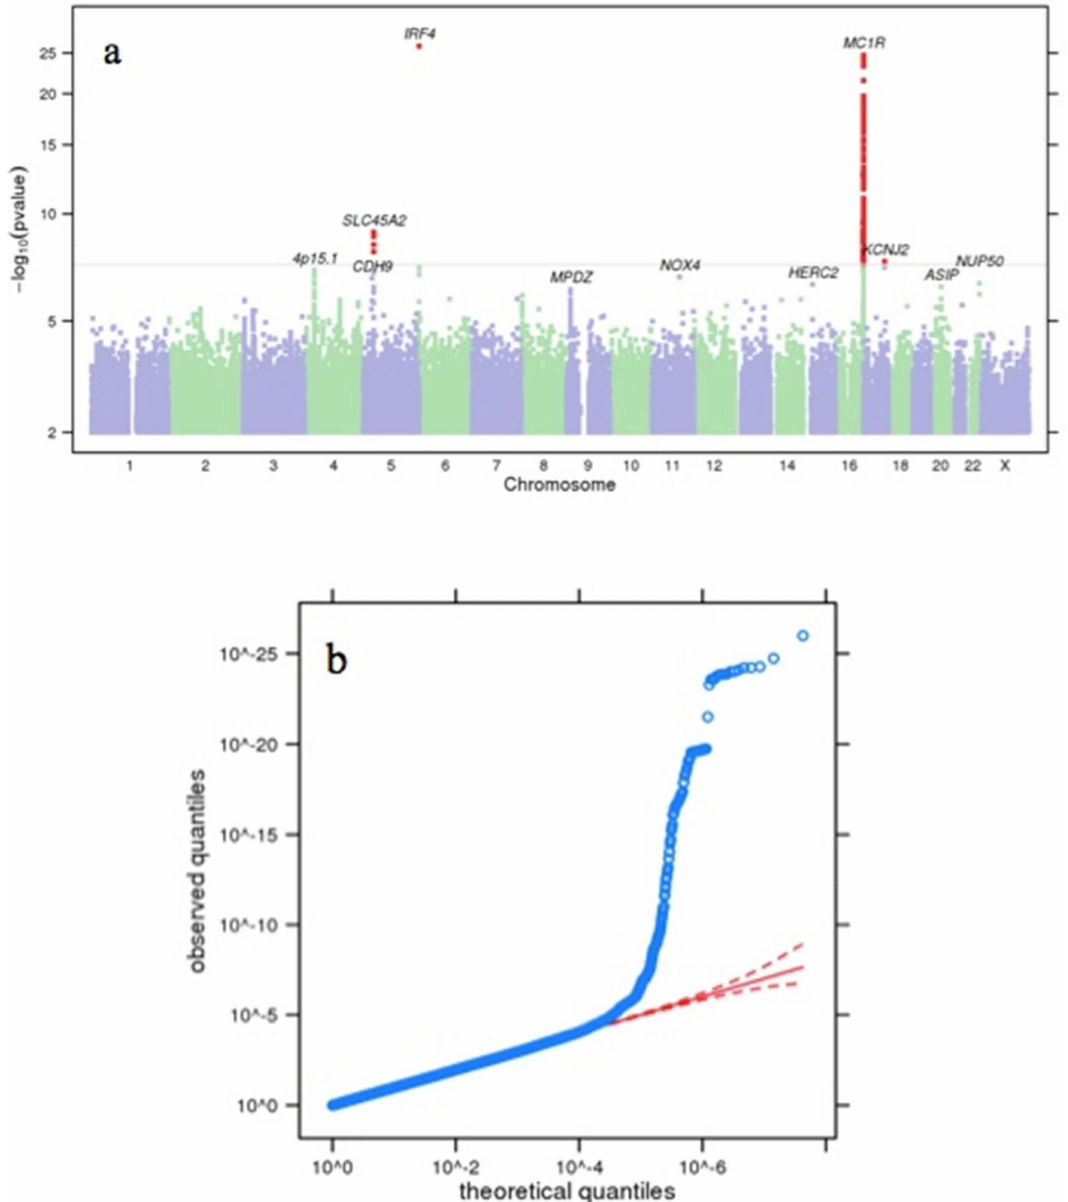
Figure 1. (a ) Manhattan plot of GWAS association results for sensitive skin. The GC-adjusted significance of association (y axis) is plotted on the di ff erent chromosomes (x axis). Those reaching a Bonferroni threshold of significance ( p -value < 5 × 10 − 8 ) are shown in red. ( b ) Q-Q plot of expected versus observed association p